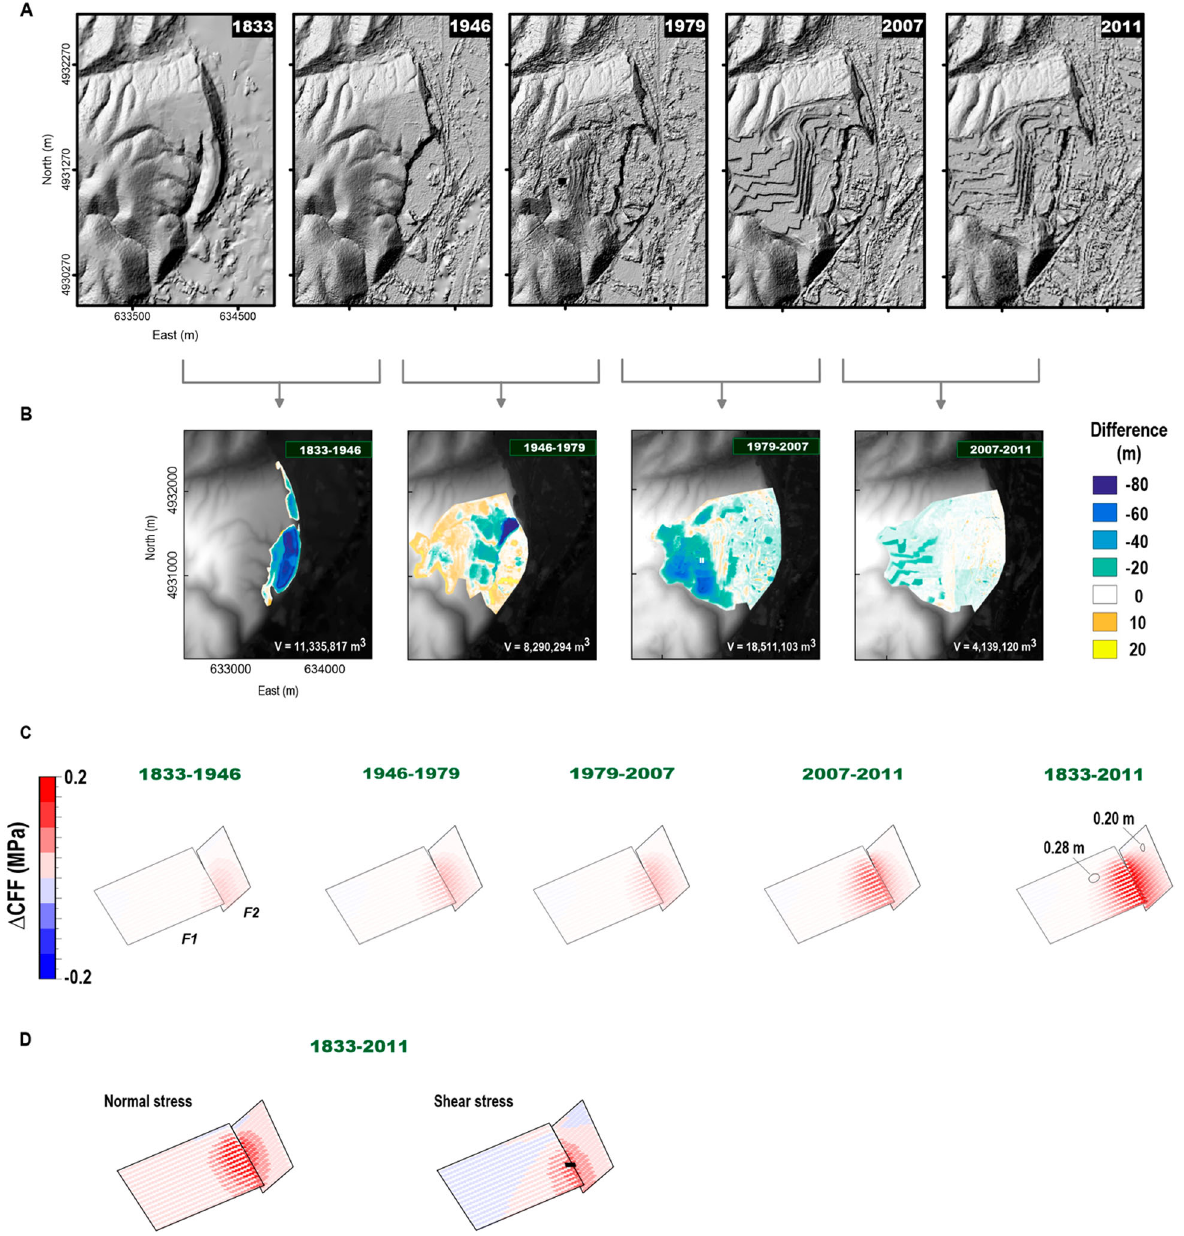
Fig. 3 Estimate of the volume removed from the quarry and Coulomb stress modeling. a Digital Surface Model (DSM) of the considered area at successive times. b Computation of the rock volumes retrieved by numerically comparing the available DSM. c Coulomb stress change, computed for μ ′ = 0.4, caused by the mass removed from the Le Teil quarry on the fault planes associated with the 2019 earthquake. The black contours in the rightmost panel outline the area with coseismic slip larger than 0.28 m for F1 and larger than 0.20 m for F2 . d Normal and shear stress components of the Coulomb stress change for the whole analyzed period. The small black square indicates the point where the shear stress illustrated in Fig. 4 is